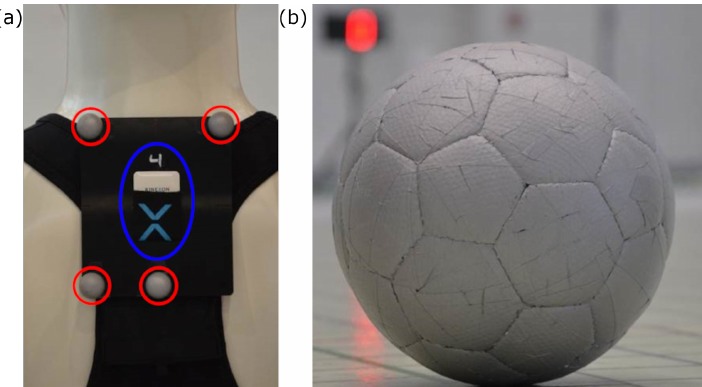
Figure 2. ( a ) Kinexon tag attachment (blue circle) and reference system marker arrangement (red circles). ( b ) Ball as reflective reference system marker with Kinexon sensor